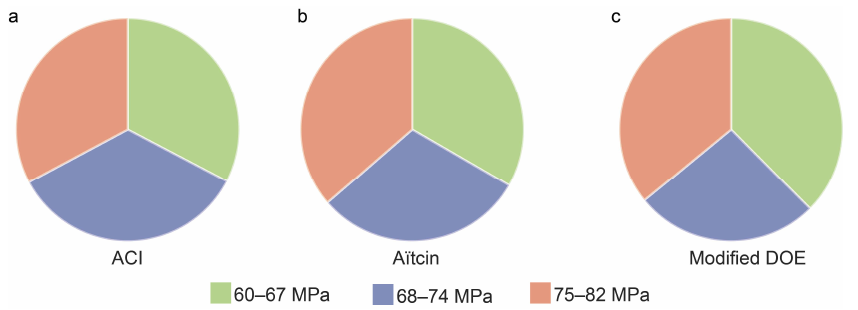
Figure 2. Training data produced by the mix design programs showing uniformity in distribution of compressive strength in the three classes: ( a ) ACI, ( b ) Aïtcin, and ( c ) Modified DOE.